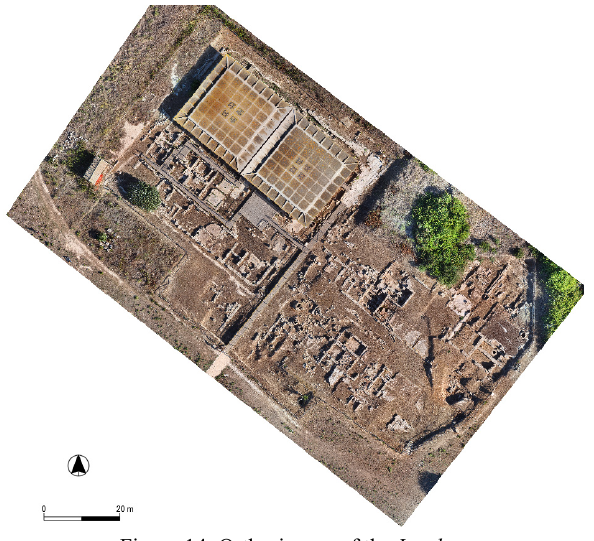
Figure 14. Ortho-image of the Insulae .